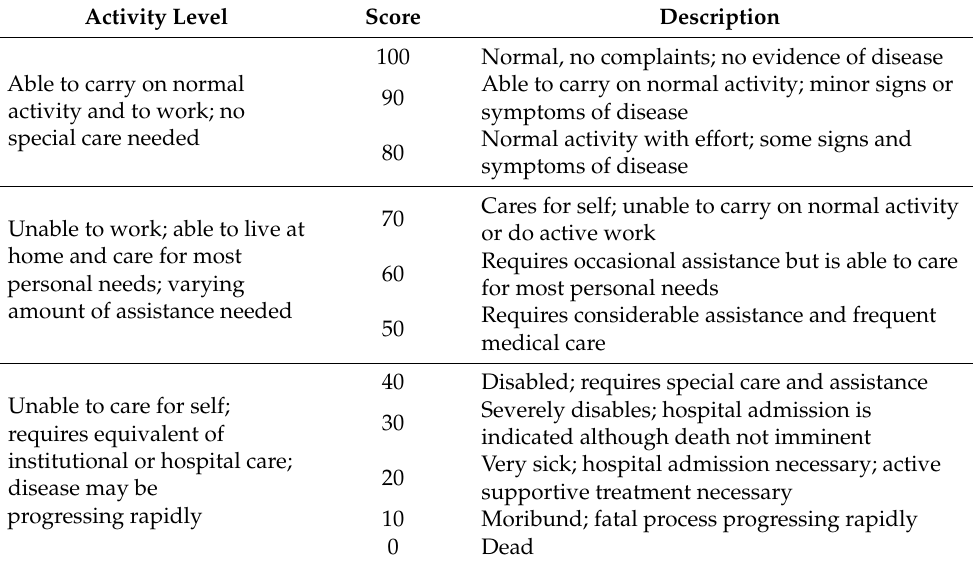
Table 1. Karnofsky performance